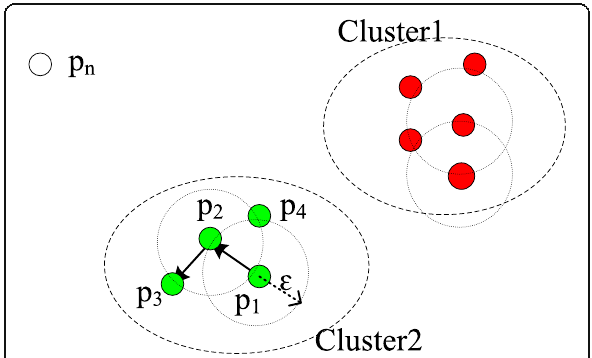
algorithm. The DBSCAN algorithm is a data clustering algorithm proposed by Martin Ester which is